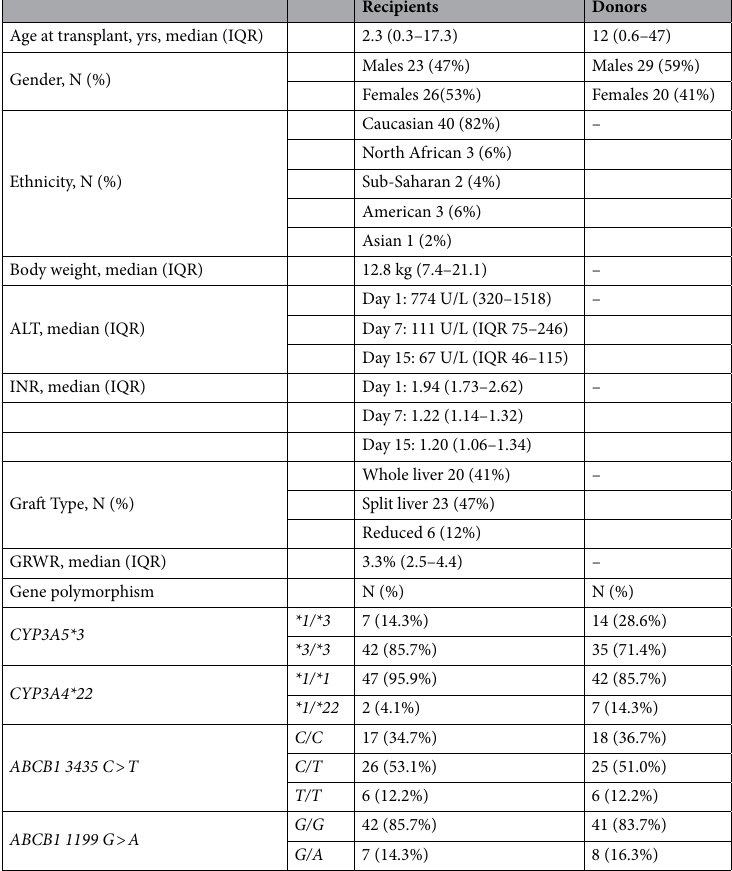
Table 1. Patients baseline features at the date of transplantation and graft characteristics. GRWR, Graft-to- Recipient Weight